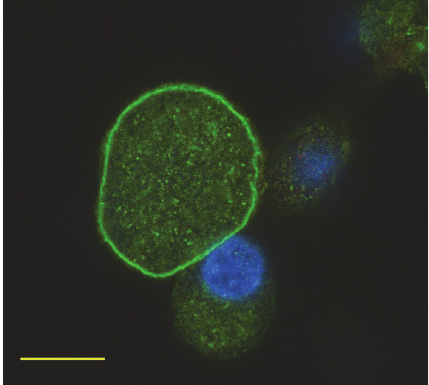
Figure 1: Confocal optical sections of cultured sensory neurons treated with prokineticin 2 (100nM) for 30 seconds and sub- sequently fixed and stained for PKC 𝜀 with a polyclonal specific antibody. Nuclei were stained in blue with DAPI. The largest neuron is showing translocation of PKC 𝜀 to the plasma membrane; the smaller neurons represent a typical example of nontranslocated neurons. Translocation induced by 1 𝜇 M bradykinin (BK) for 30 seconds had identical appearance. Scale bar: 5 𝜇